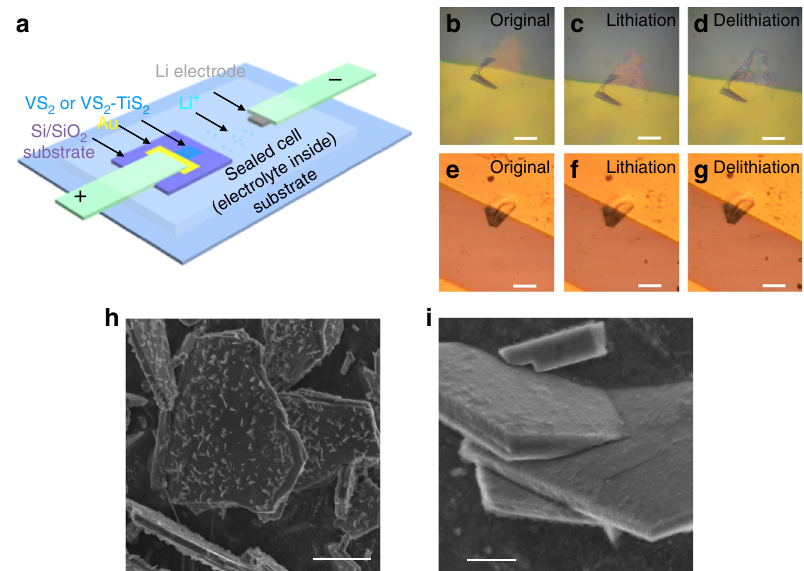
Fig. 4 Observations of structural changes to the VS 2 and VS 2 -TiS 2 fl akes during the lithiation and delithiation process. a Schematic of transparent cell set-up for in situ optical imaging. b − d Optical images of VS 2 fl ake at the original status, lithiation status, and delithiation status. Scale bar = 20 μ m. e − g Optical images of VS 2 -TiS 2 fl ake at the original status, lithiation status, and delithiation status. Scale bar = 20 μ m. The color difference of the background shown in ( b − d ) and ( e − g ) was caused by using a different light source of the optical microscope. h Ex situ SEM image (scale bar = 10 μ m) of VS 2 fl akes after galvanostatic charge − discharge cycling at 1000 mA g − 1 for 400 cycles. i Corresponding SEM image (scale bar = 3 μ m) of VS 2- TiS 2 fl akes after galvanostatic charge − discharge cycling at 1000mA g − 1 for 400 cycles. SEM scanning electron